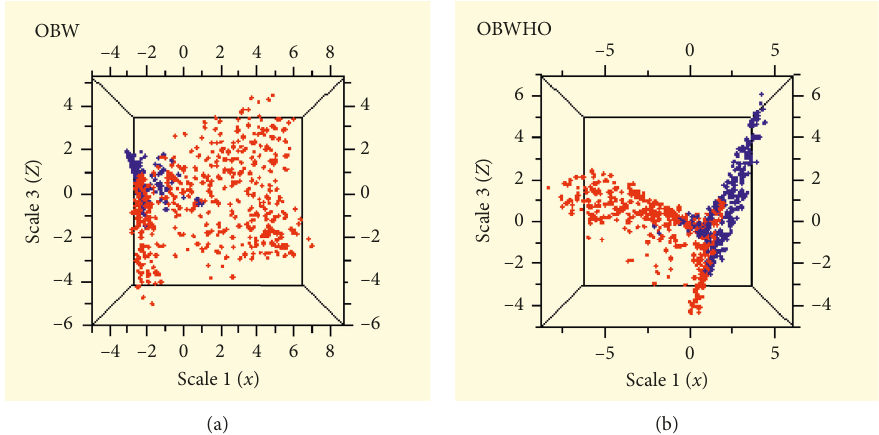
Figure 3: Tree-based clustering of subjects who were obese (in blue) versus those who were not obese (in red), for obesity as defined by (a) waist circumference (OBW) and (b) BMI